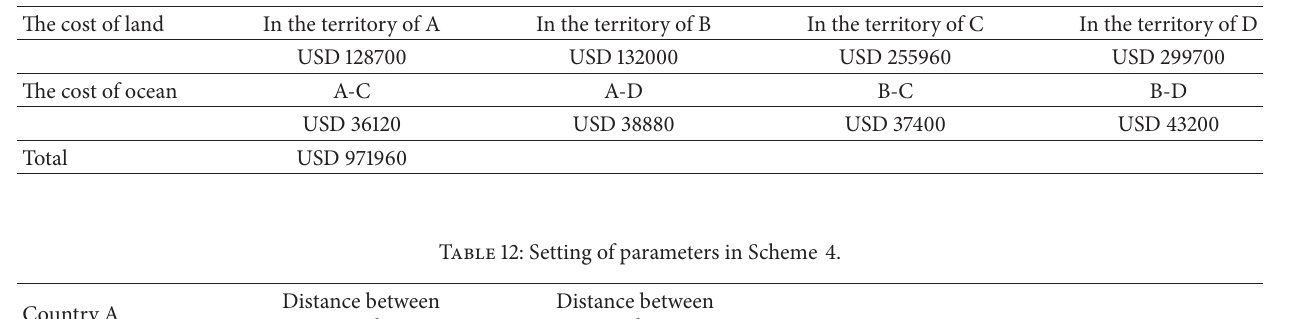
Table 11: Simulation results of freight cost in Scheme 3.